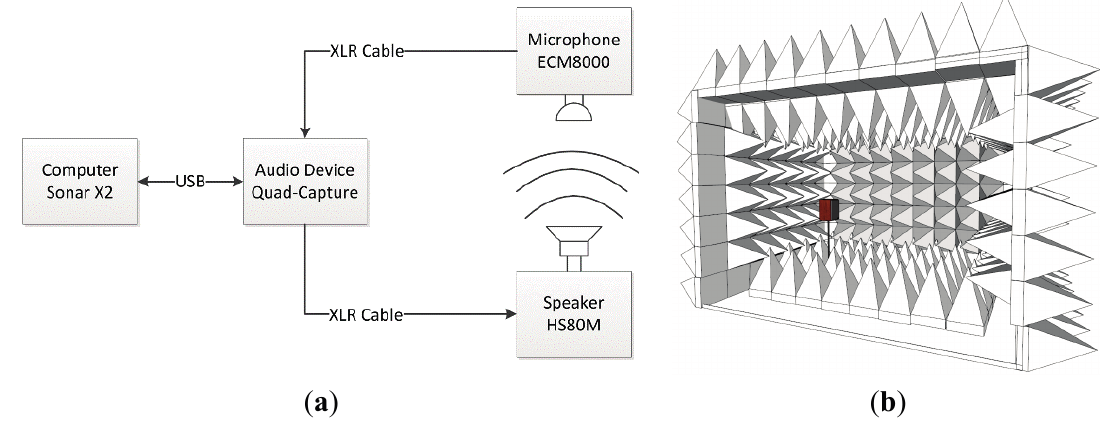
Figure A1. ( a ) Measurement configuration; ( b ) Perspective sketch of anechoic